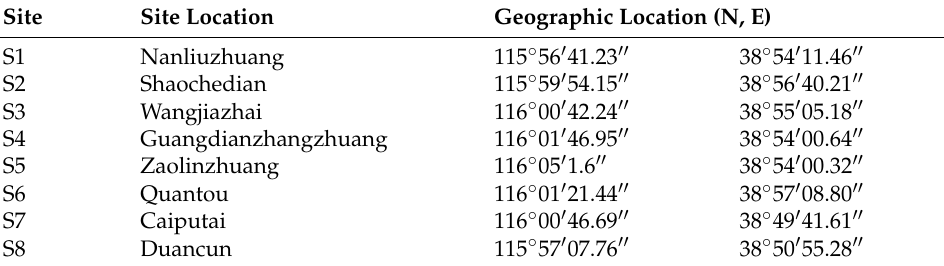
Figure 1. Map of the sampling sites in Baiyangdian Lake. Table 1. Location of the sampling sites in Baiyangdian Lake.